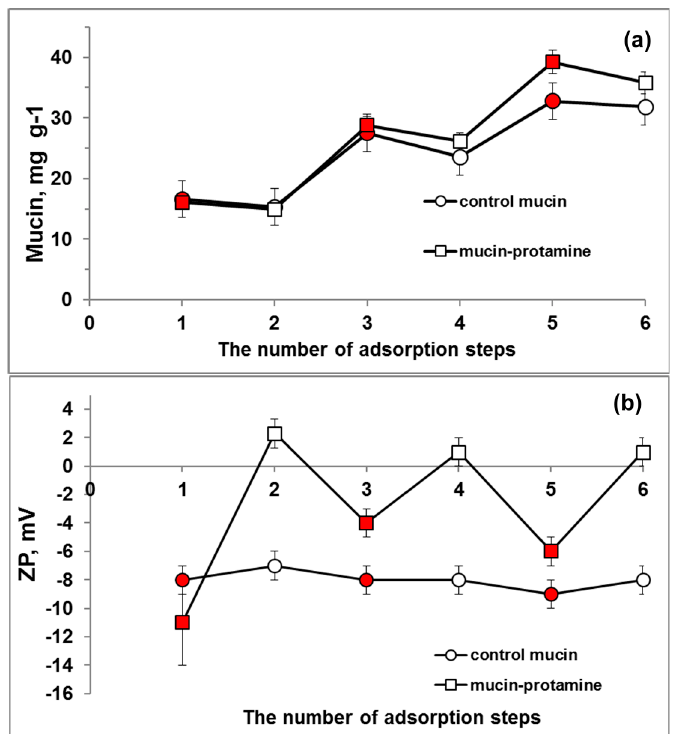
Figure 8. The content of mucin ( a ) and the zeta potential ( b ) of mucin-containing crystals ( n = 1) as a function of a number of deposition steps of either mucin or water (control) or mucin and protamine pairs. Т he adsorption of mucin is indicated with a red colour.